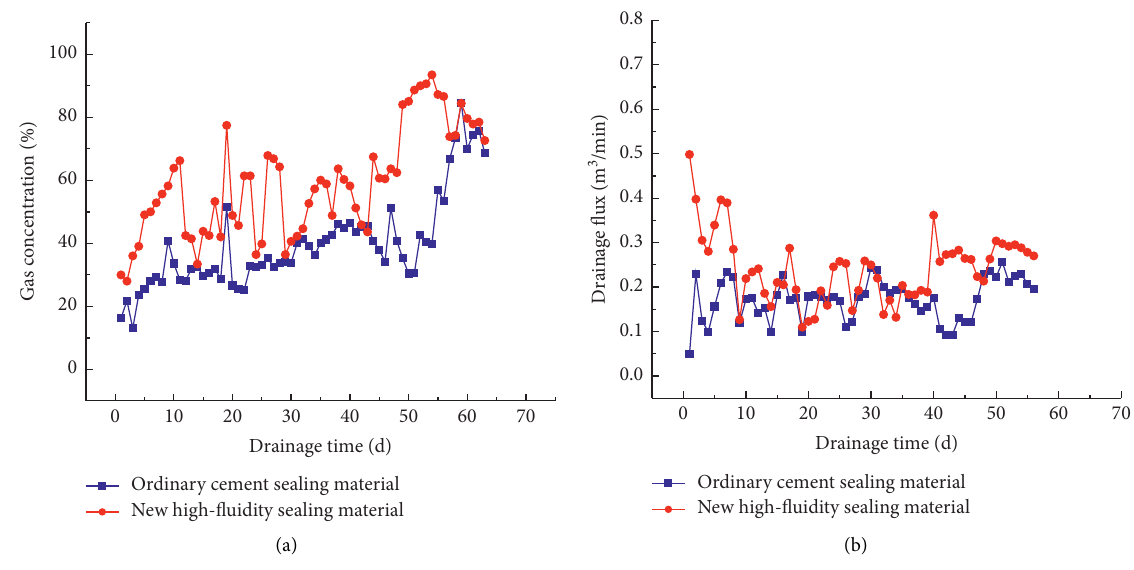
Figure 15: Two sets of borehole gas concentration and flux with